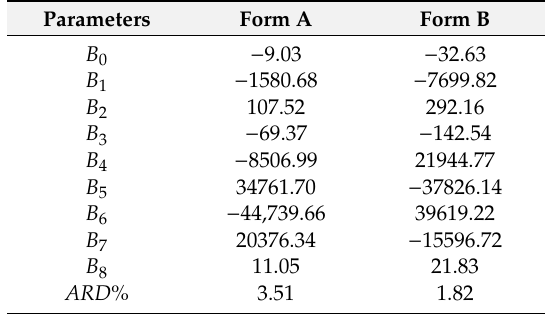
Table 7. Parameters of modified Jouyban–Acree model for MTBE + toluene